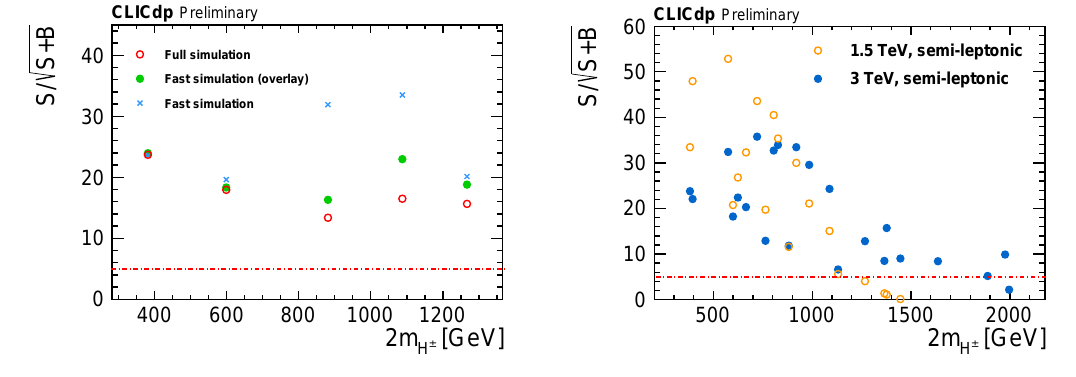
Figure 2: Histograms of the mass of a di-jet system (left) and a single jet (right), obtained using different simulation methods for signal HP17 at line shows the full simulation, azure the fast simulation and blue the fast simulation with overlay contribution.